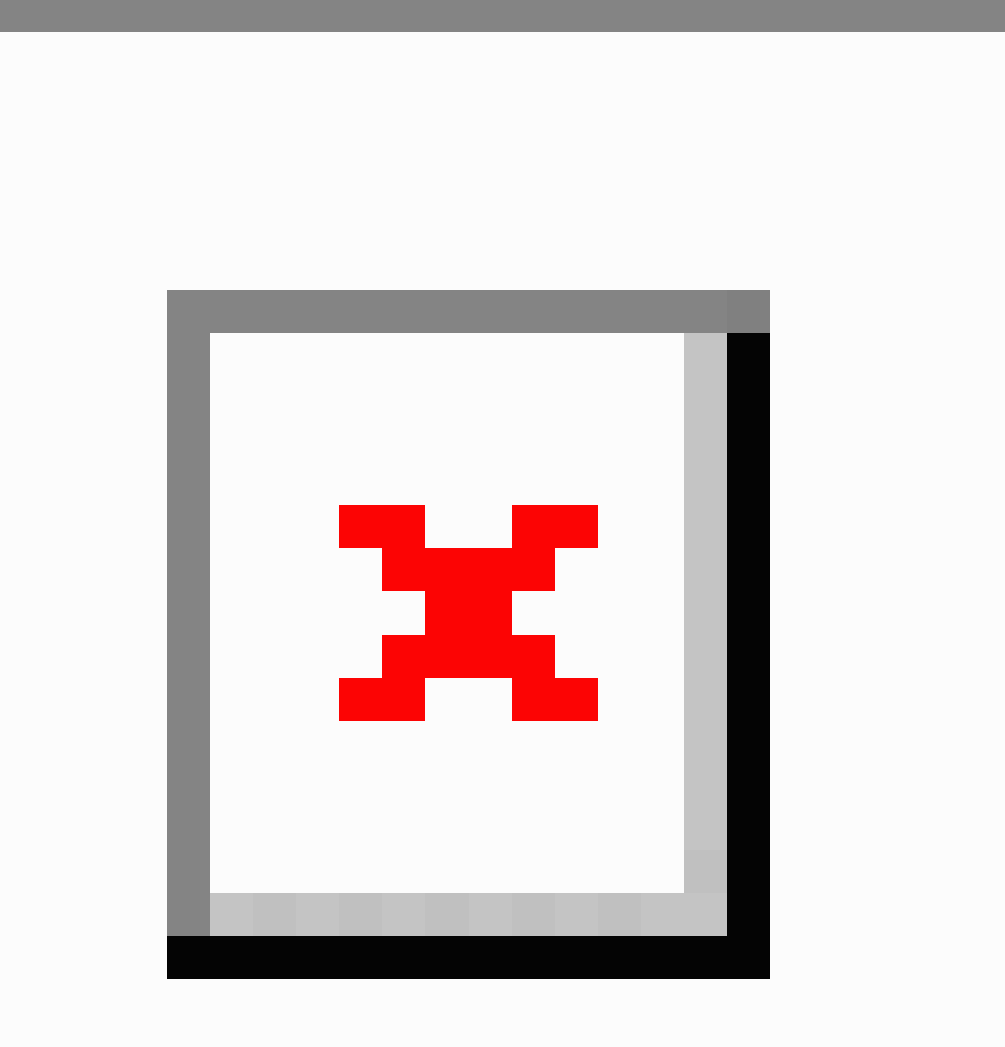
Figure 2. In version 1, the y-axis provides a measure for activity, while the x-axis provides a measure for intensity. The DPA goal is met when the blue ball (representation of current activity status) is kept in the green circle at all times. The widget shows a current status towards reaching a DPA goal (pilot study